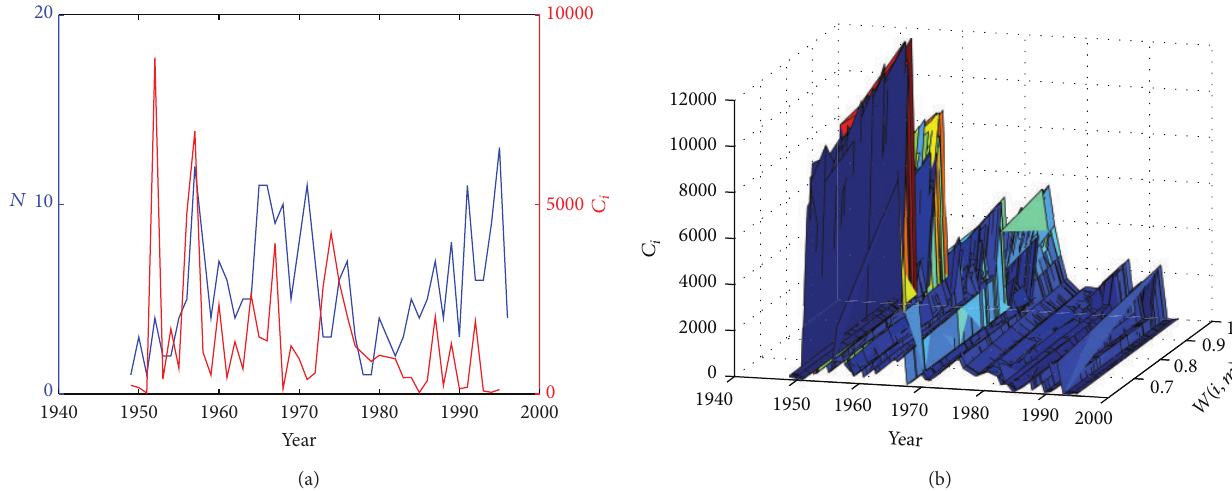
Figure 4: Total articles 𝑁 and innovation ability 𝐶 𝑖 for TD Lee. (a) 𝑁 and 𝐶 𝑖 versus year; blue line denotes total number of papers; red line is creative ability; (b) ( 𝐶 𝑖 , 𝑊(𝑖,𝑚) ) versus year.